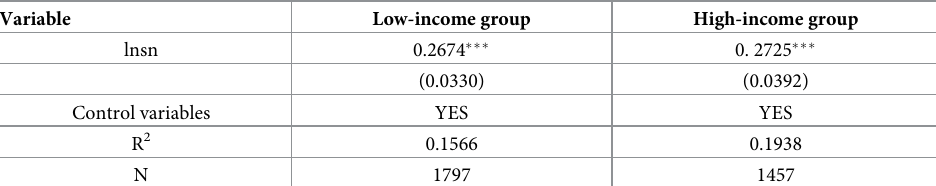
Table 6. Estimations of income class.